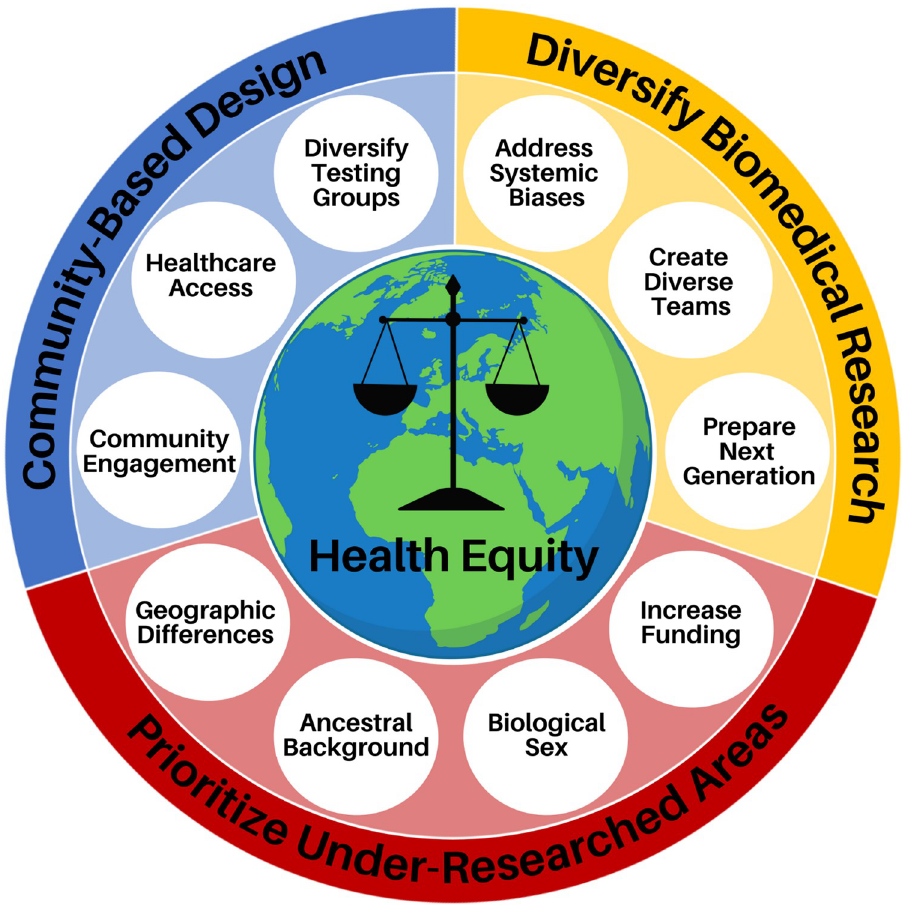
Fig 1. Overview of 10 simple rules in biomedical engineering to improve healthcare equity divided into 3 categories: (i) improving diversity and equity in biomedical research; (ii) increasing research of under investigated areas; and (iii) considering diverse communities in the research design process. Image created with